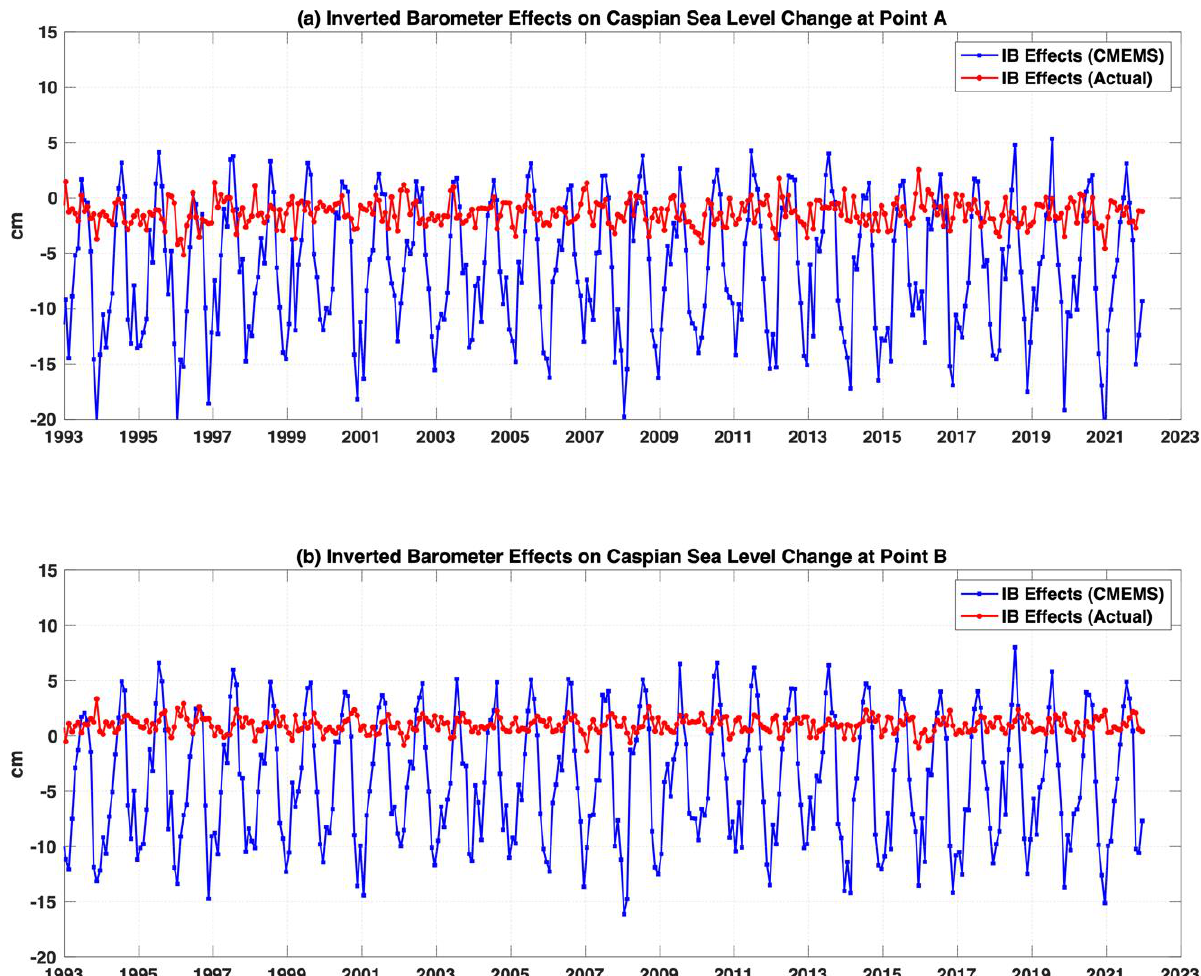
Figure 6. Comparisons of the actual and CMEMS approximate IB effects in two selected points ( a ) A and ( b ) B in the Caspian Sea over the period January 1993 to December 2021 based on the ECMWF ERA5 atmospheric model data (Points A and B are marked by the “+” in Figure 5a). After applying the improved or actual IB corrections to the CMEMS SLA grids over the Caspian Sea, we recompute the CMEMS CSL change series and compare it with the Hydroweb CSL series in Figure 7. The two altimeter CSL change results agree remarkably well and the discrepancies noted earlier are almost completely gone. The annual and semiannual amplitudes and phases and linear trend of the recomputed CMEMS CSL change series are estimated from unweighted least-squares fit and listed in Table 1 (row 3) for comparisons. With the improved IB correction, the mean annual amplitude of the CMEMS CSL is increased from 8.72 ± 1.30 cm to 15.79 ± 1.30 cm, and agrees well with the Hydroweb estimates (17.03 ± 1.33 cm). The RMS of the residuals between the Hydroweb and CMEMS CSL estimates is reduced from 6.88 cm to 3.14 cm. As mentioned above, the IB correction, if implemented correctly, does not affect the CSL change estimates. To compute CMEMS CSL change, we can equivalently undo or remove the approximate IB correction applied to the CMEMS SLA